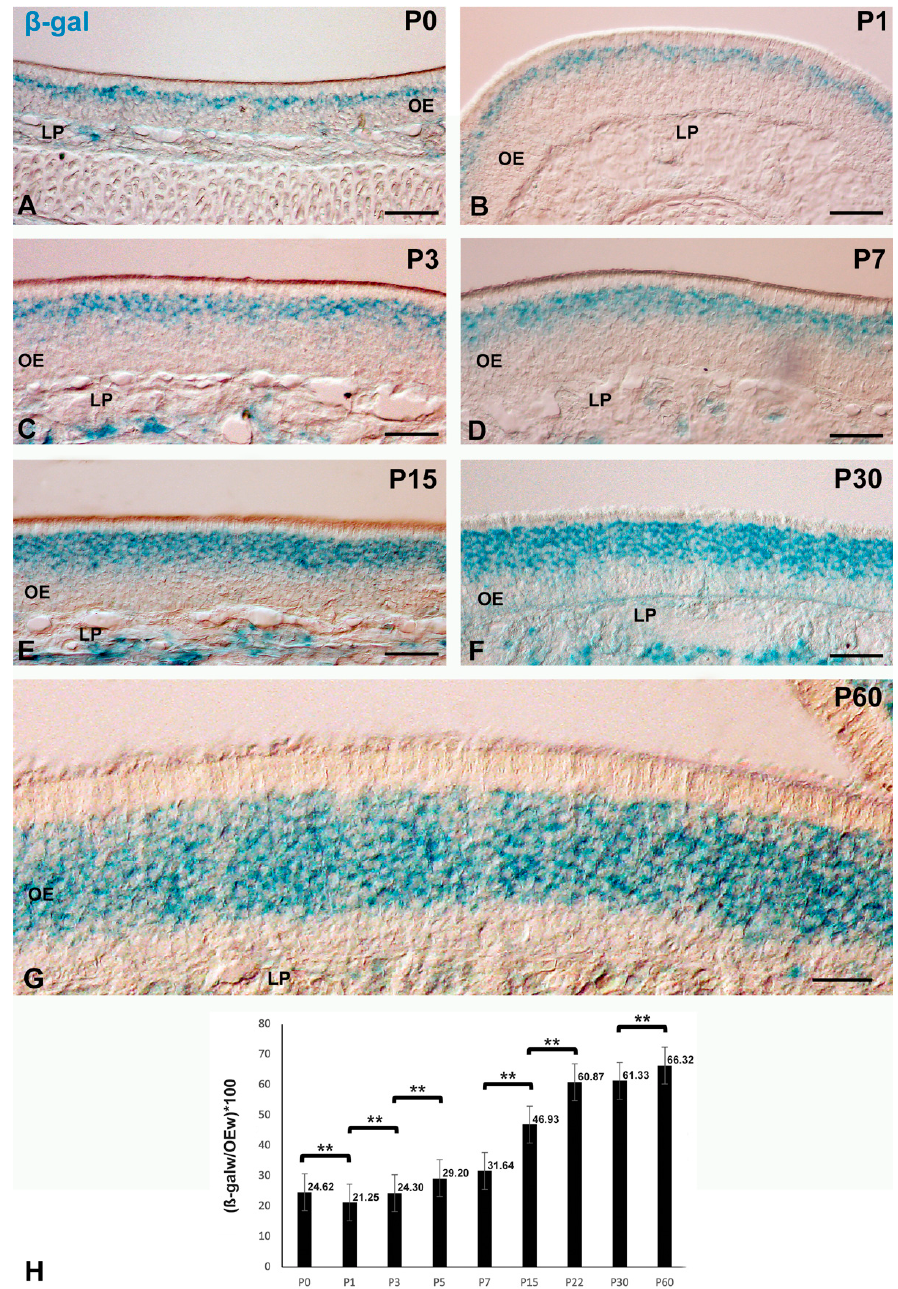
Figure 2. The presence of β -gal-pH6 histochemical staining in the developing olfactory epithelium of P0 ( A ), P1 ( B ), P3 ( C ), P7 ( D ), P15 ( E ), P30 ( F ), and P60 ( G ) mice. β -gal-pH6 staining was restricted to the intermediate zone of the olfactory epithelium. ( H ) Quantitative analysis of the relationship between the width of the band of β -gal-pH6 staining and the thickness of the olfactory epithelium (OEw) during postnatal mouse development. Data are expressed as mean ± SEM. Statistical signifi- cance is indicated by asterisks (* p < 0.05, ** p < 0.01). The width of the β -gal-pH6 staining band increased progressively with age. LP, lamina propria; OE, olfactory epithelium . Scale bars: 100 μ m in A – F ; 50 μ m in G .